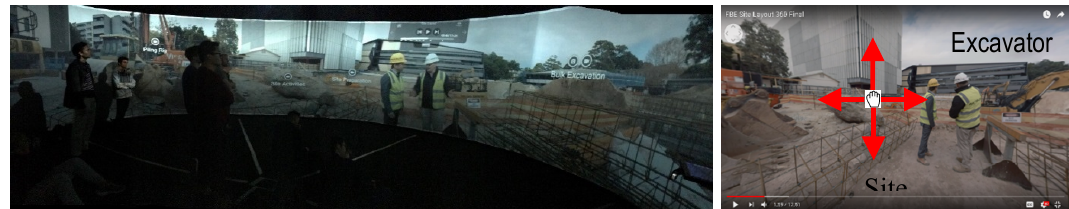
Figure 5. Panning of an iCRT module sample module used for the case course [66,67] (See: https: // www.youtube.com / channel / UCOzhGK8xOdoCc3Y9mJHnAnA /